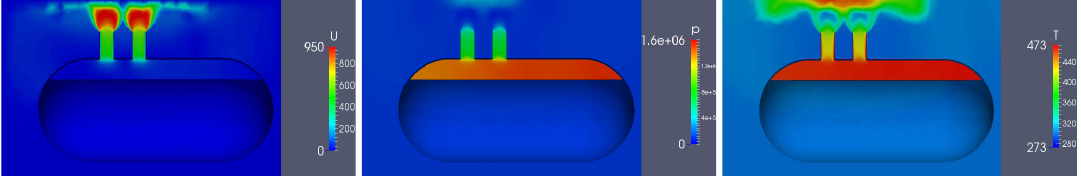
Figure 10. The velocity, pressure and temperature distribution in PRT and interior space at 0.02